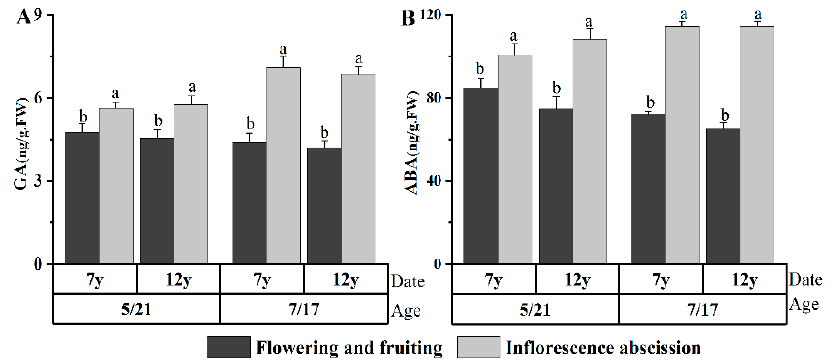
Figure 4. Di ff erences in the endogenous hormones between flowering and fruiting plants and nonflowering plants at di ff erent growth stages. The di ff erent letters reflect significant di ff erences among di ff erent indexes in the same stage.